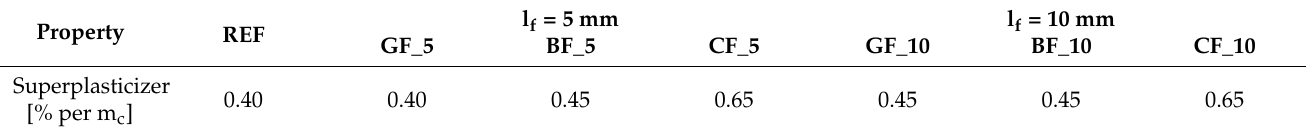
Table 3. Superplasticizer quantities depending on the type and quantity of